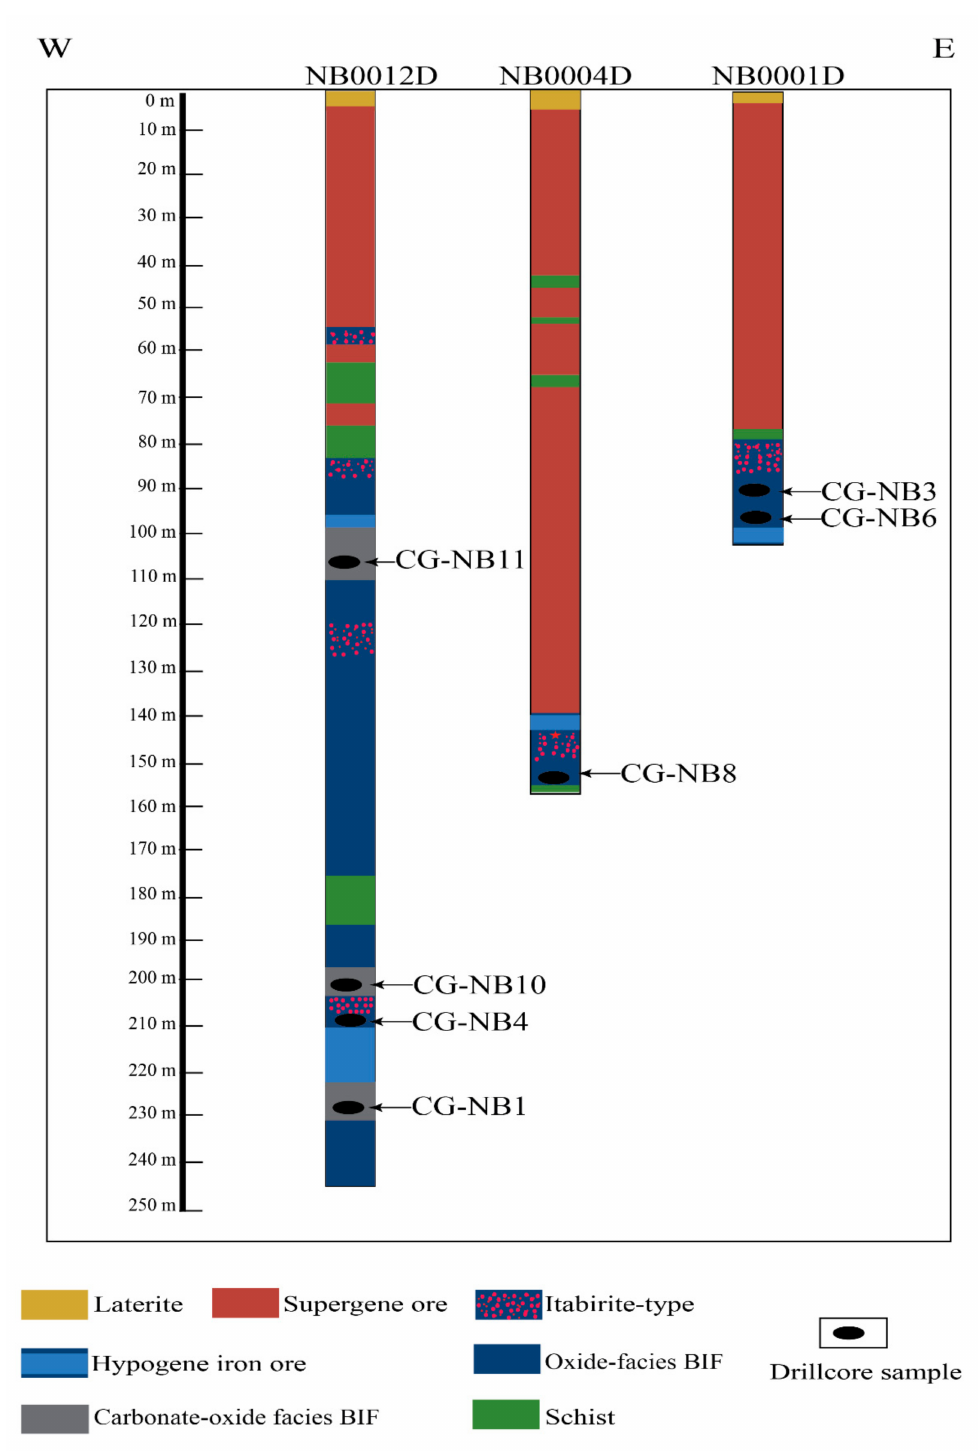
Figure 3. Drill-hole stratigraphic columns at the Nabeba BIF